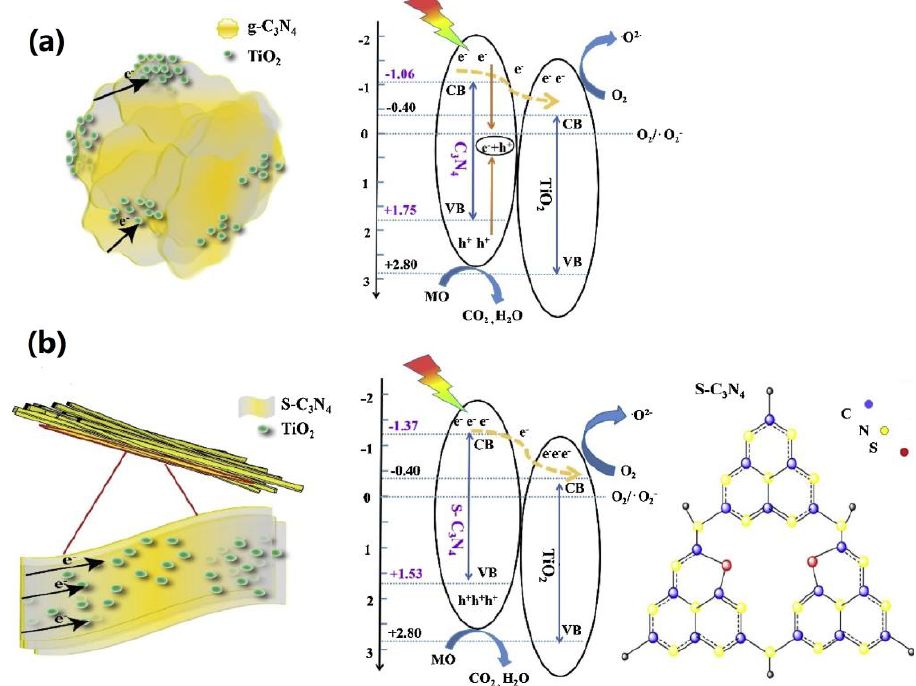
Figure 15. Mechanism of fast charge transfer at the interface between ( a ) C 3 N 4 -TiO 2 and ( b ) S-C 3 N 4 /TiO 2 . Reprinted with permission from [109]. Copyright 2017, Elsevier.